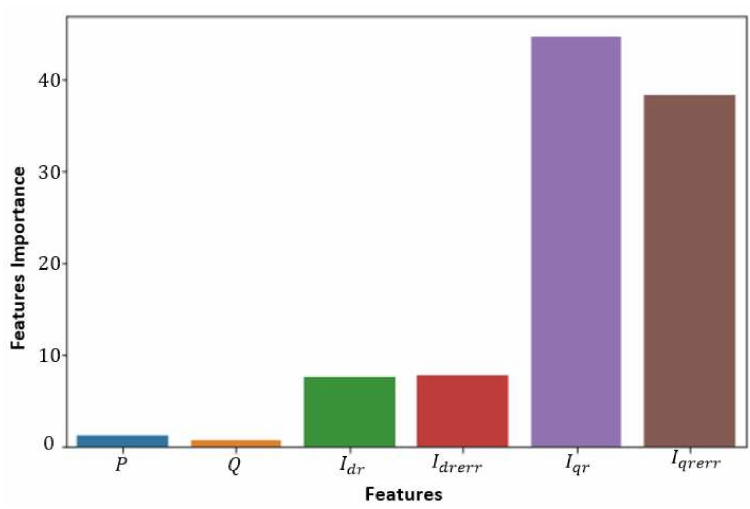
Figure 6. Feature importance of Catboost classifier at 1340 RPM and 50% loaded